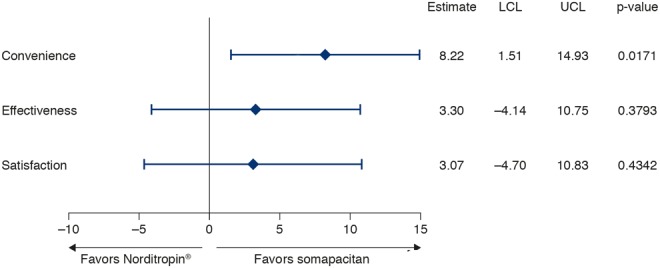
Estimated treatment difference in change in TSQM-9 scores at Week 26. Full analysis set. Estimates are from a mixed model for repeated measurements. LCL, lower confidence limit; TSQM-9, Treatment Satisfaction Questionnaire for Medication-9; UCL, upper confidence limit.